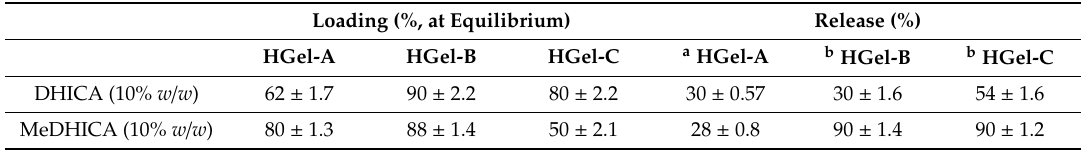
Figure 8. Release kinetics of the incorporated indoles from HGel-B ( A ) and HGel-C ( B ) in PBS with refreshing of the medium at 37 °C over 6 h. Reported are the mean ± SD values of three experiments and the polynomial regression that fits the data. Table 1. Overview of the percentage values of loading and release of the indole compounds from the gelatin hydrogels investigated. Loading (%, at